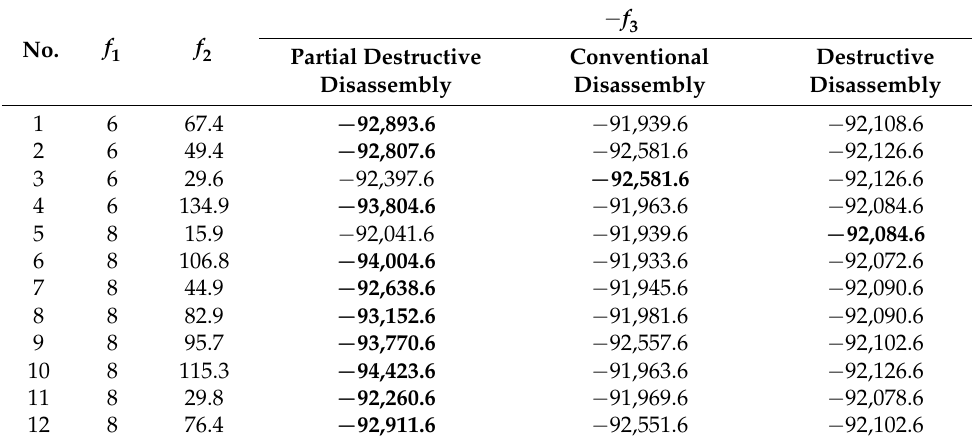
Table 4. The computational result of NSGA-II.